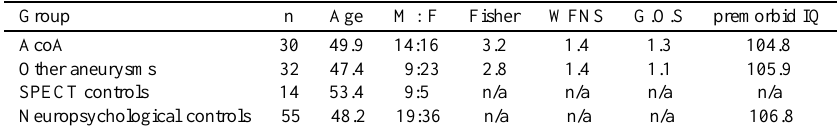
Table 2 Demographics and clinical indicators of patients ( n = 62 ) and control